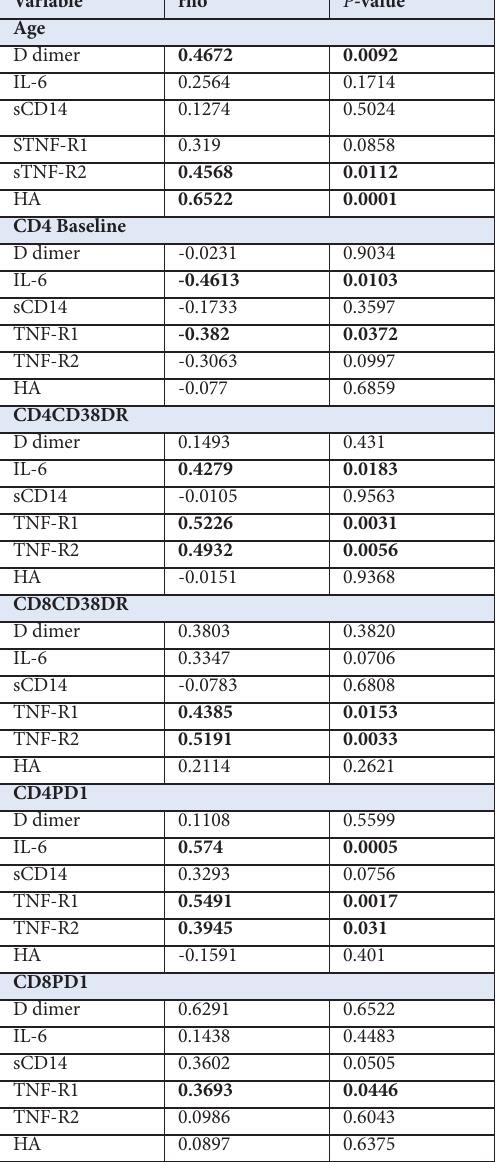
Correlations between markers of Monocyte Activation and Demographic and Clinical